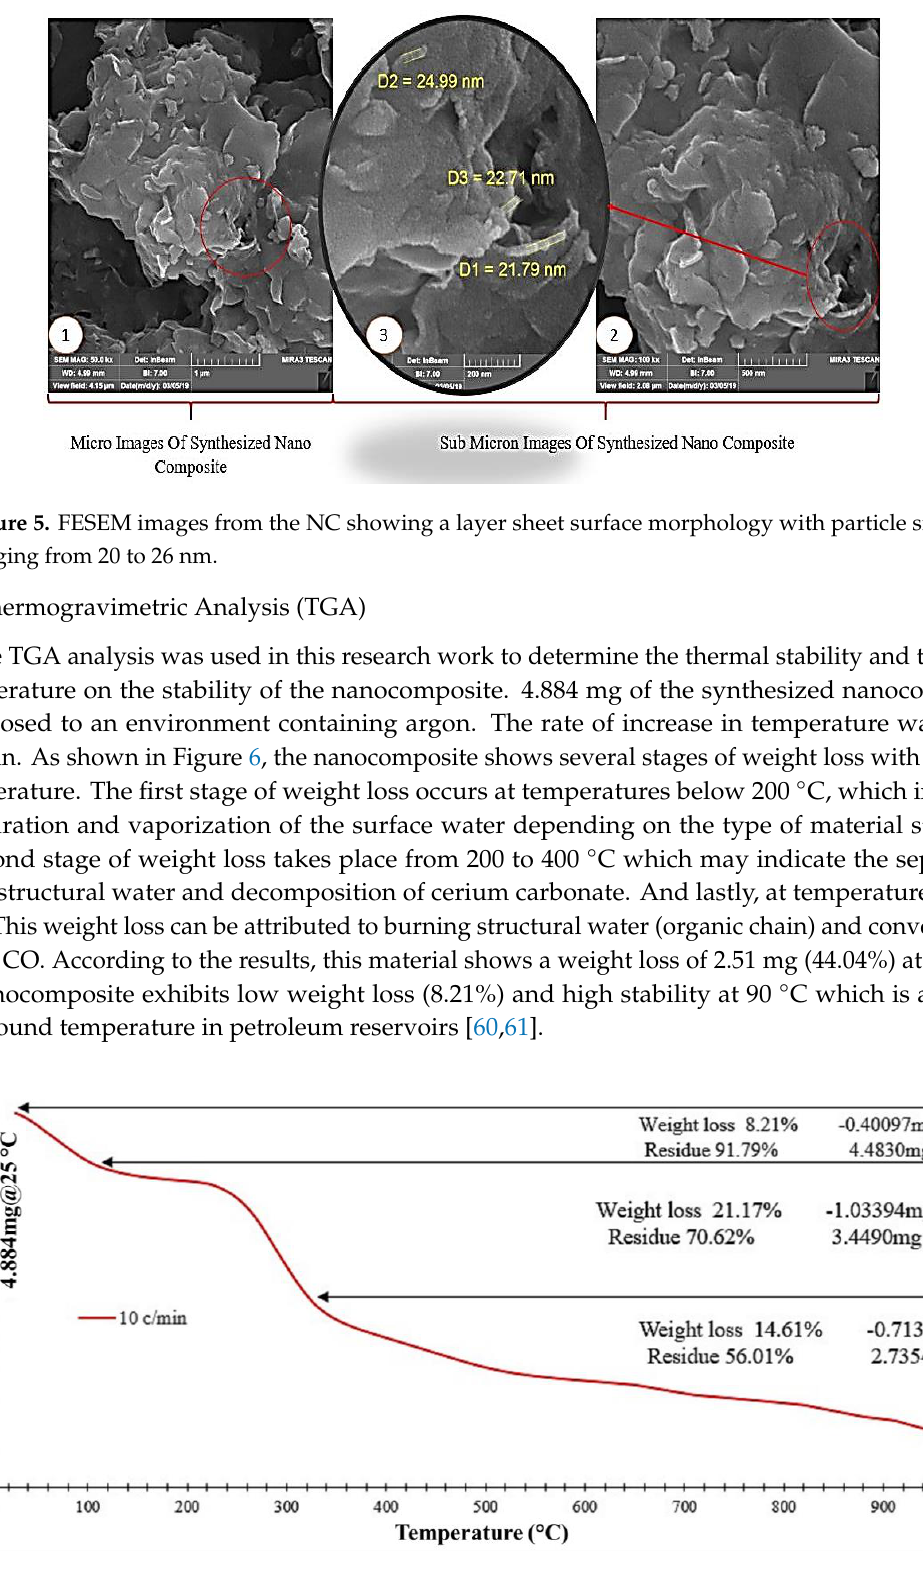
Figure 6. TGA analysis result used to investigate the thermal stability of the novel NC. The novel NC has a low weight loss of 8.21% and a high stability at 90 °C, which is a typical upper bound temperature in petroleum reservoirs.